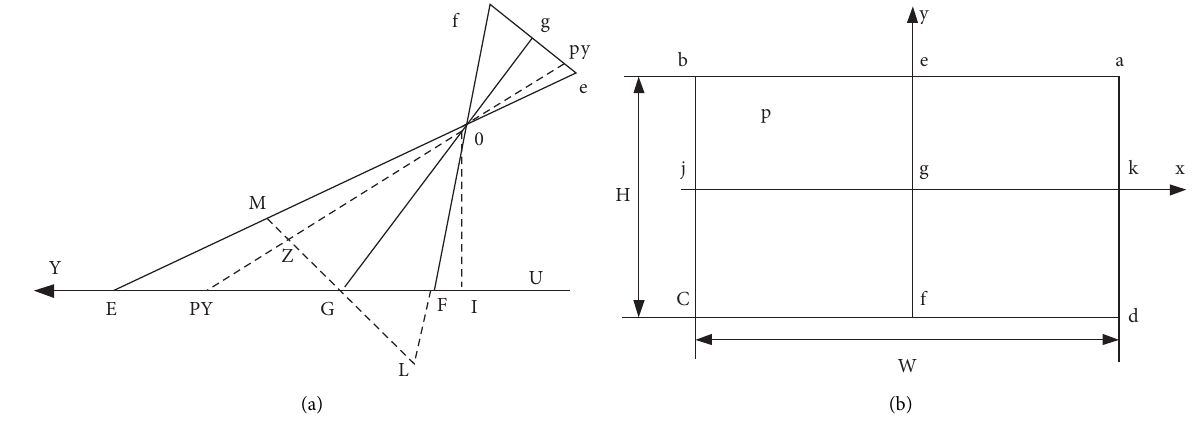
Figure 2: Te imaging geometry of the target point in the Y -axis